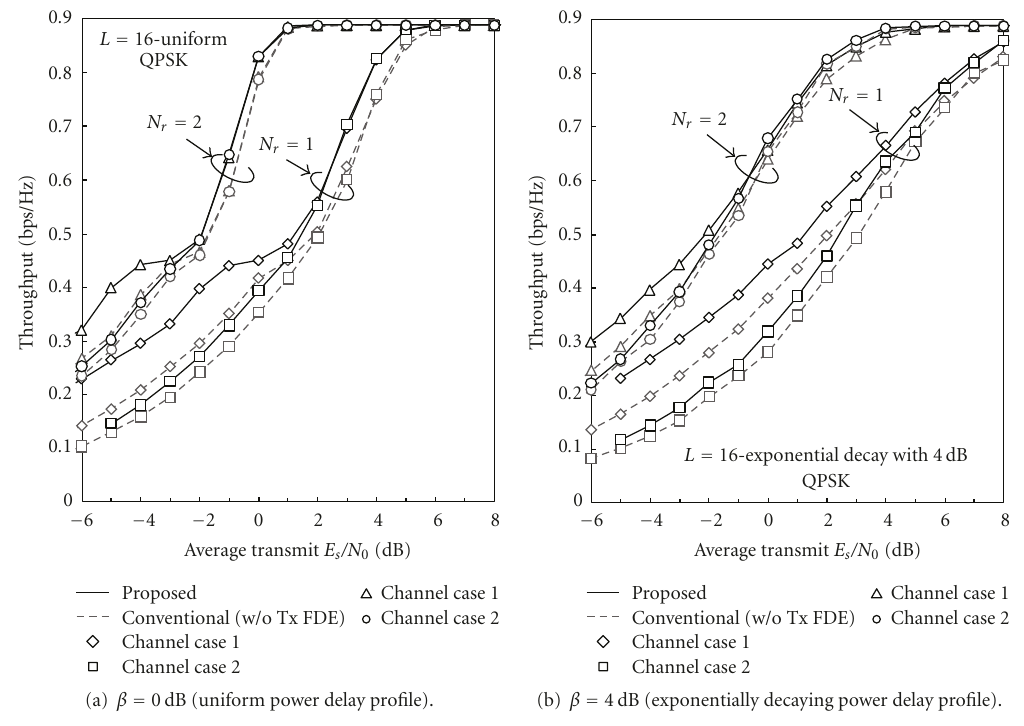
Figure 8: HARQ throughput with QPSK.